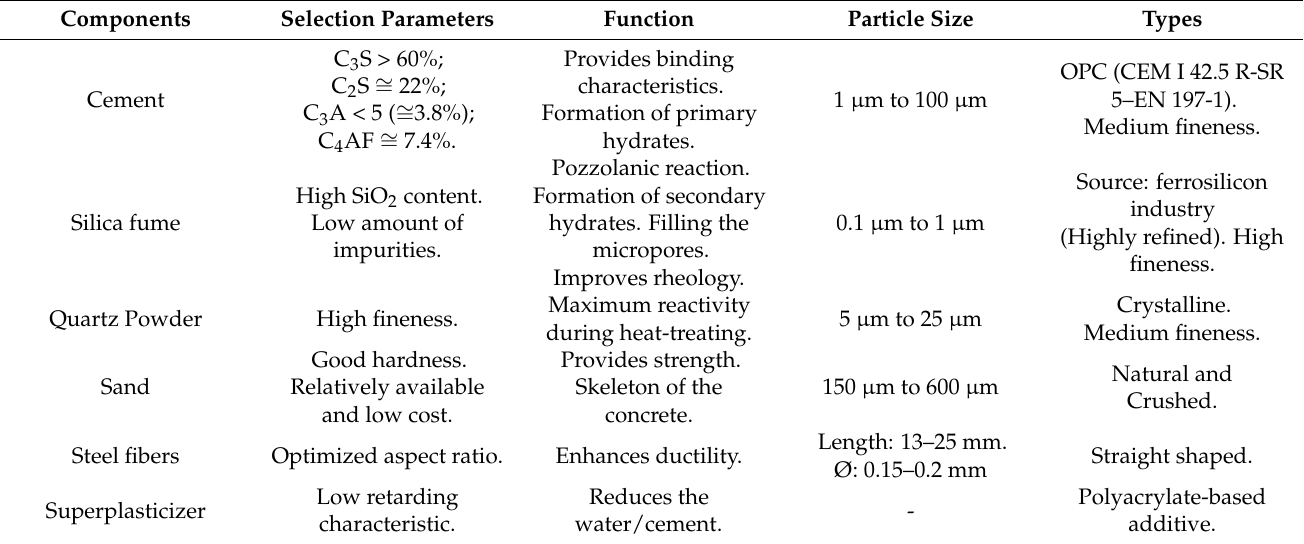
Table 1. Parameters selection for reactive powder concrete